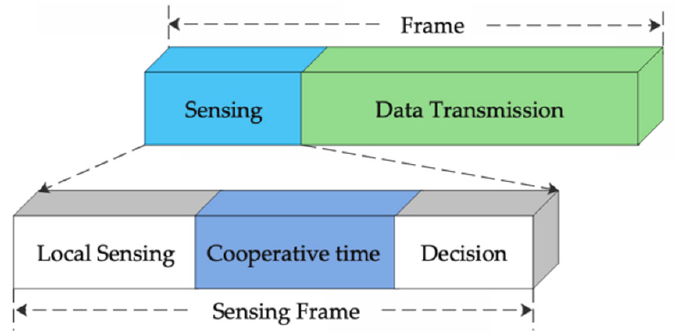
Figure 2. The slot structure of the primary channel for secondary users (SUs).